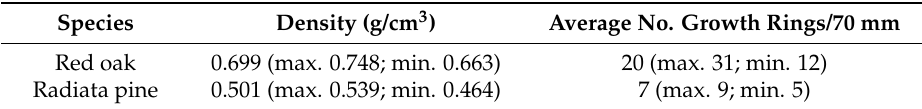
Table 2. Density of oak and pine test panels and numbers of growth rings visible on the end-grain of panels.